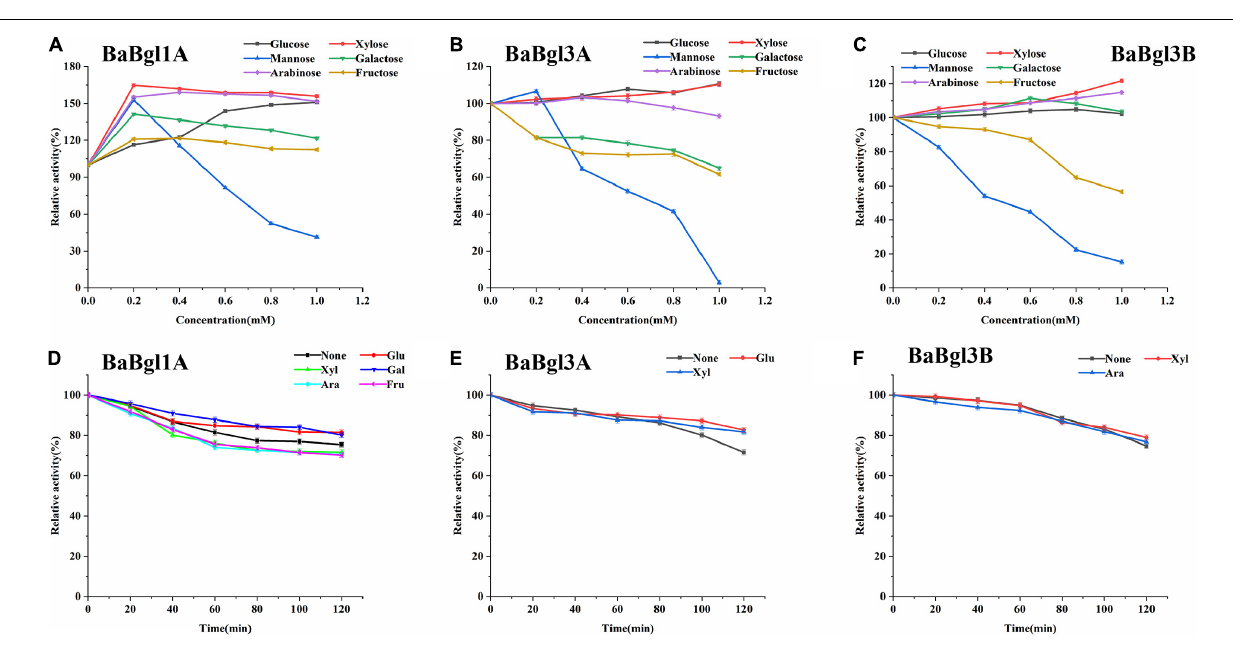
FIGURE 5 | Effects of sugar and stability on BaBgl1A, BaBgl3A, and BaBgl3B activity. The effects of sugar and stability on BaBgl1A are shown in (A,D) . The effects of sugar and stability on BaBgl3A are shown in (B,E) . The effects of sugar and stability on BaBgl3B are shown in (C,F) . Values are mean ± SD from three biological